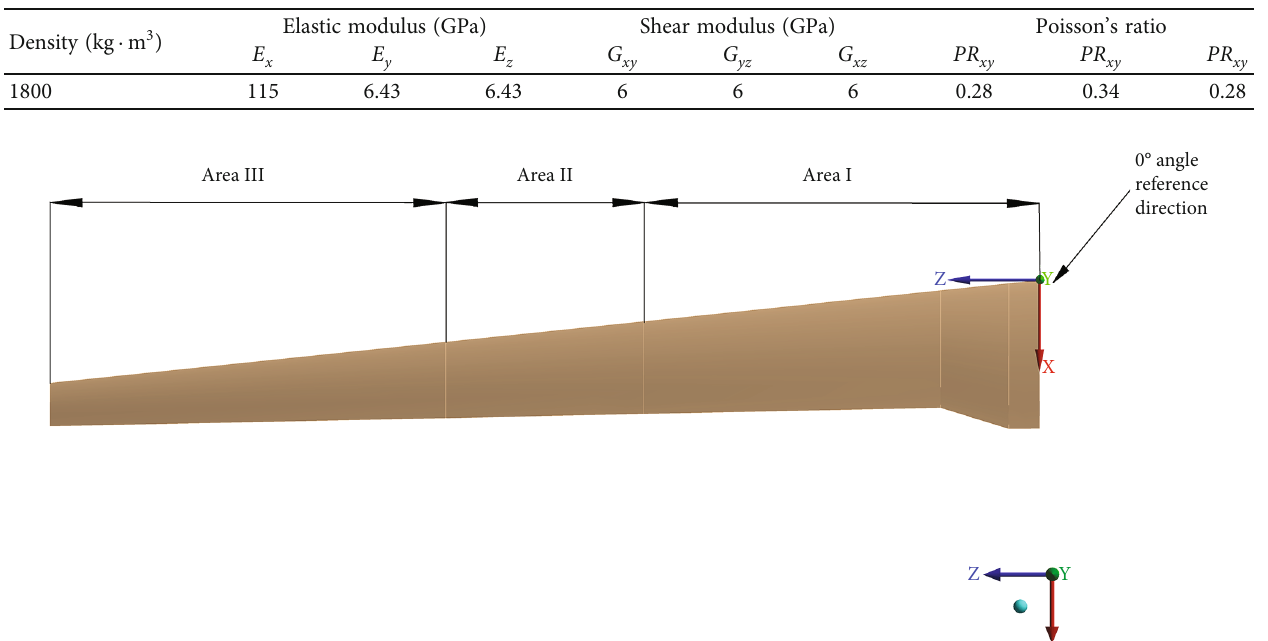
Figure 6: Wing structure and airfoil pro fi le. Table 2: UT700 material parameters.